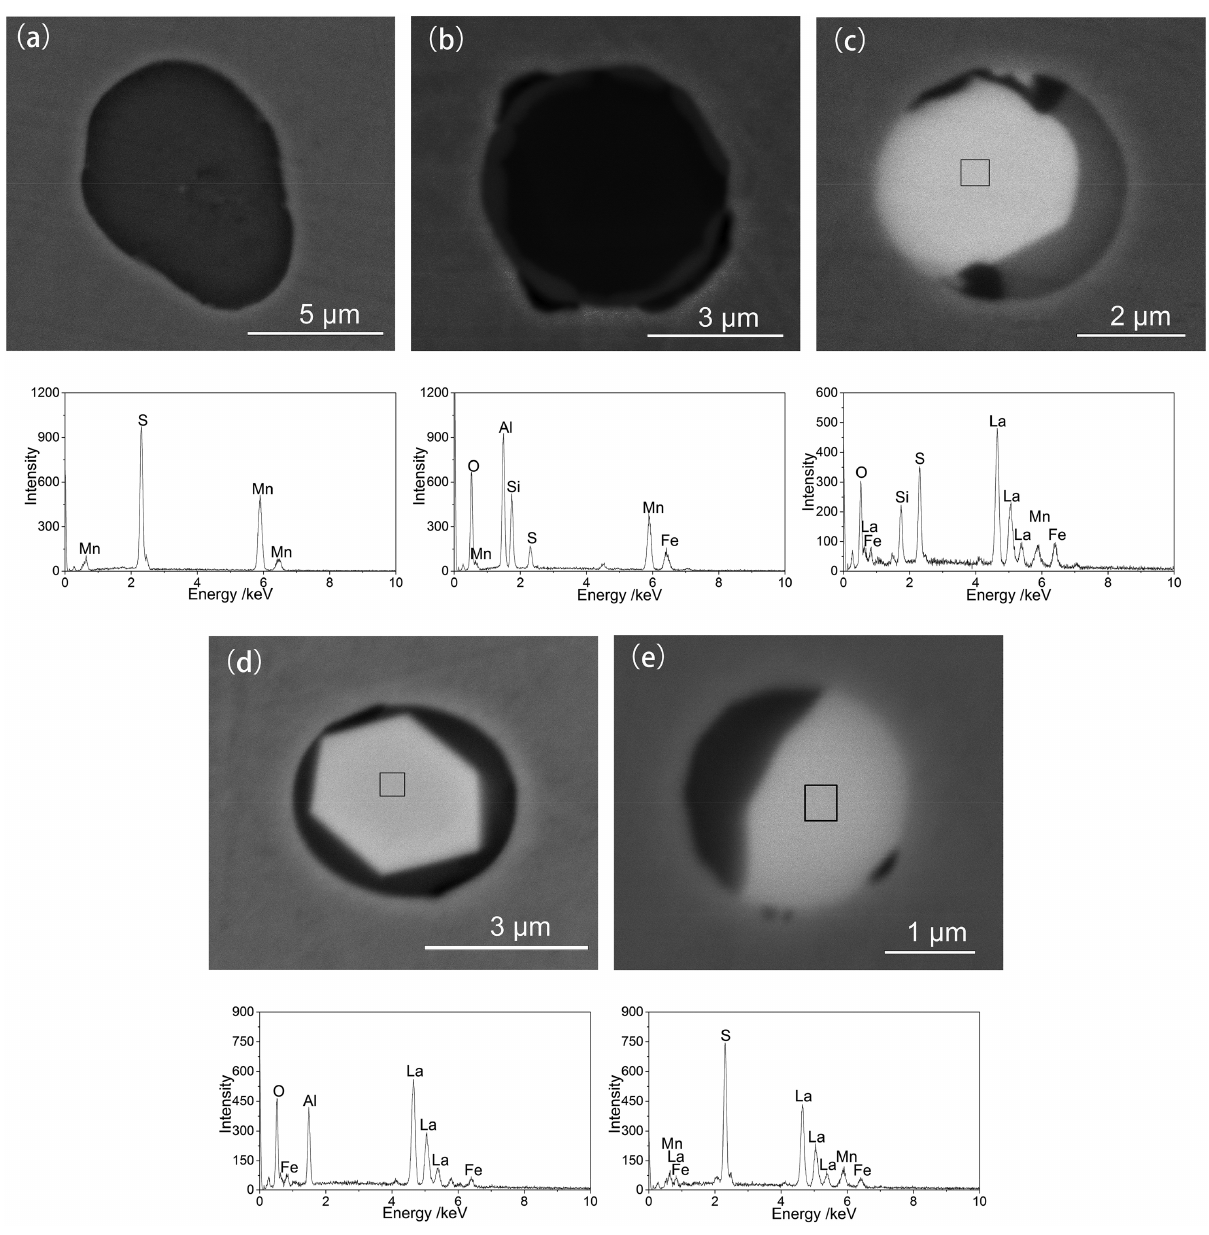
Figure 4: The micrographs and compositions of typical nonmetallic inclusions in the steels (a and b) AR1, (c) AR2, (d and e)